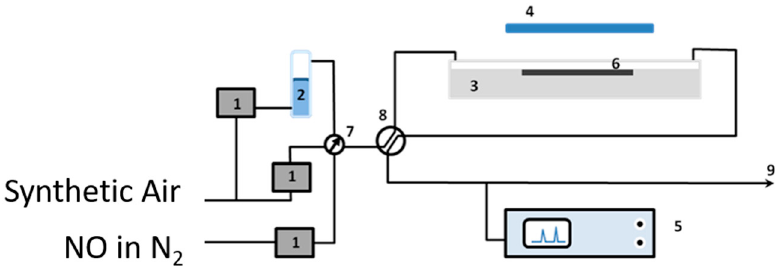
Figure 1. The photocatalytic testing apparatus: (1) mass flow controllers, (2) humidity supplier, (3) photocatalytic reactor, (4) UV(A) irradiation source, (5) NOx analyzer, (6) test sample, (7) and (8) valves, and (9) gas stream outlet.